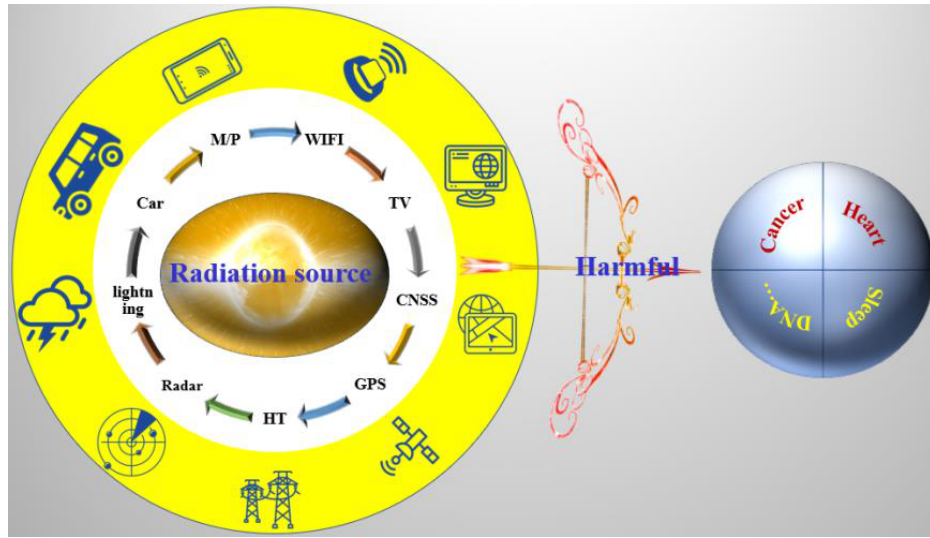
Figure 4. Sources and hazards of electromagnetic pollution.